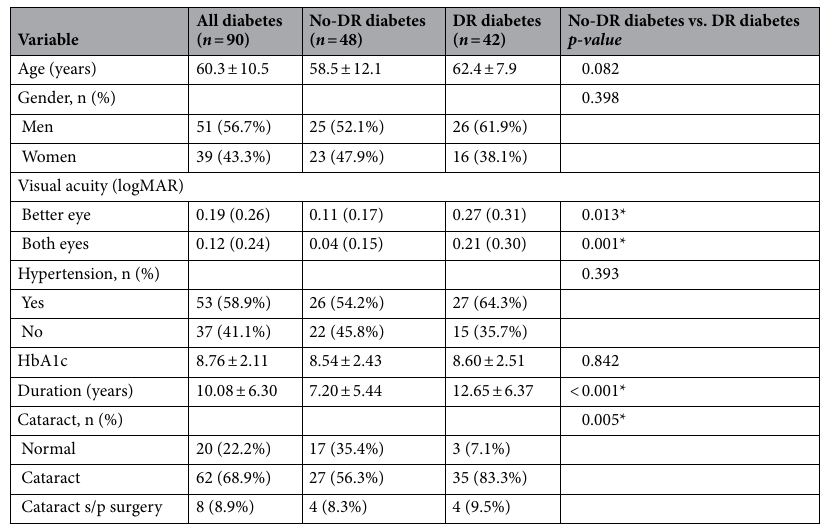
Table 1. Baseline characteristics of patients with T2DM, patients with T2DM without DR, and patients with T2DM with DR. Continuous variables are expressed as mean ± standard deviation (SD). Categorical variables are presented as n (%). logMAR logarithmic minimum angle of resolution, HbA1c hemoglobin A1c, DR diabetic retinopathy, no‑DR without diabetic retinopathy. The independent t -test and Chi-squared test were used to examine the difference between the no-DR and DR diabetes groups. The * symbol indicates significant difference ( p < 0.05).